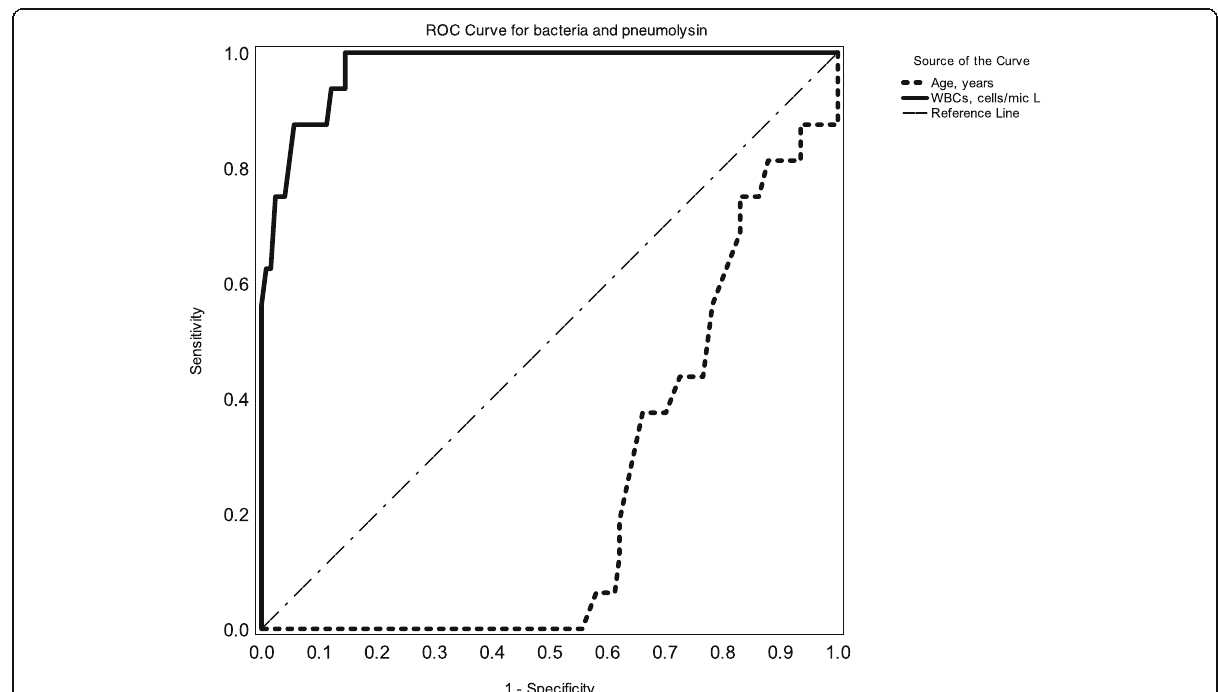
Fig. 1 ROC curve for bacteria and pneumolysin showing age and leukocytic count predictors. The solid line represents leukocytic count. Its area under the curve is 0.97 (95% CI 0.95 – 1.0), p < 0.001. The thick dotted line represents age. Its area under the curve is 0.24 (95% CI 0.14 – 0.33), p = 0.001. The dotted line is the reference line